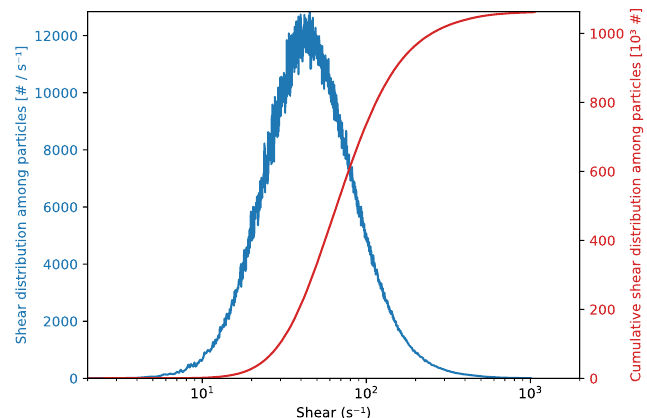
Figure 9. Shear rate distribution among particles: ∂ N / ∂ ˙ γ in blue and N ( ˙ γ ) from Equation (18) in red.